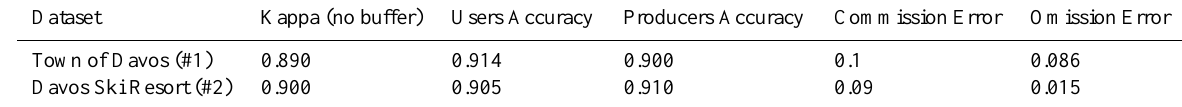
Table 3. Accuracy of the avalanche classification algorithm versus the manual digitizing methods.